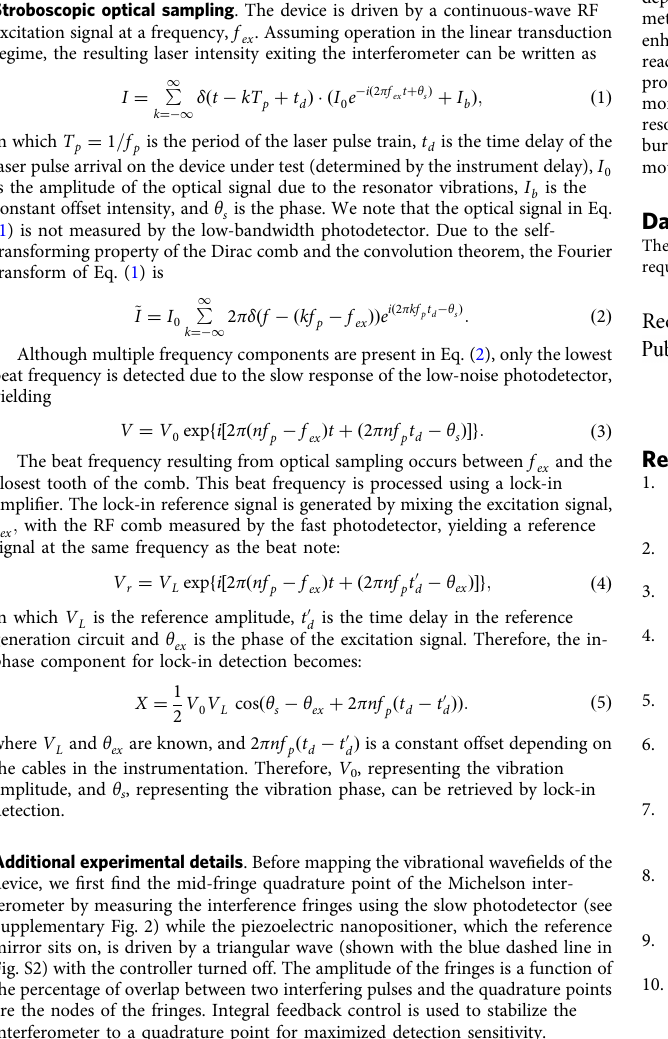
Fig. 1a. After passing the non-polarizing beam splitter and upon entering the Michelson interferometer at the broadband 50/50 polarizing beam splitter, the laser is split into the measurement arm and the reference arm. The reference arm mirror is mounted on a piezoelectric nanopositioner used for motion of a few micrometers with nanometer resolution, which sits on a piezoelectric stepper stage used for larger motion. Controlled motion of this mirror is used to adjust the optical path length of the reference arm so that its length is the same as the measurement arm, and it stabilizes the sensitivity of the interferometer by locking to the quadrature point of the fringes. The difference between the optical path lengths of the two arms needs to be smaller than 36 µm (or equivalently 120 fs) so that the two pulses interfere. The spacing between two neighboring pulses is 6 m (or equivalently 20 ns), which guarantees that there is only one laser pulse cir- culating in the interferometer at any time. The measurement arm focuses the probe pulses onto the device under test using an IR-compensated 20× apochro- matic long working distance microscope objective, while the device is mounted on a three-axis scanning nanopositioner, allowing for mapping of the vibrational wave fi eld. The beams re fl ected by the two arms of the interferometer recombine at the same beam splitter where they were split and exit the interferometer for measurement. A CCD camera is used for device alignment and to tune the image